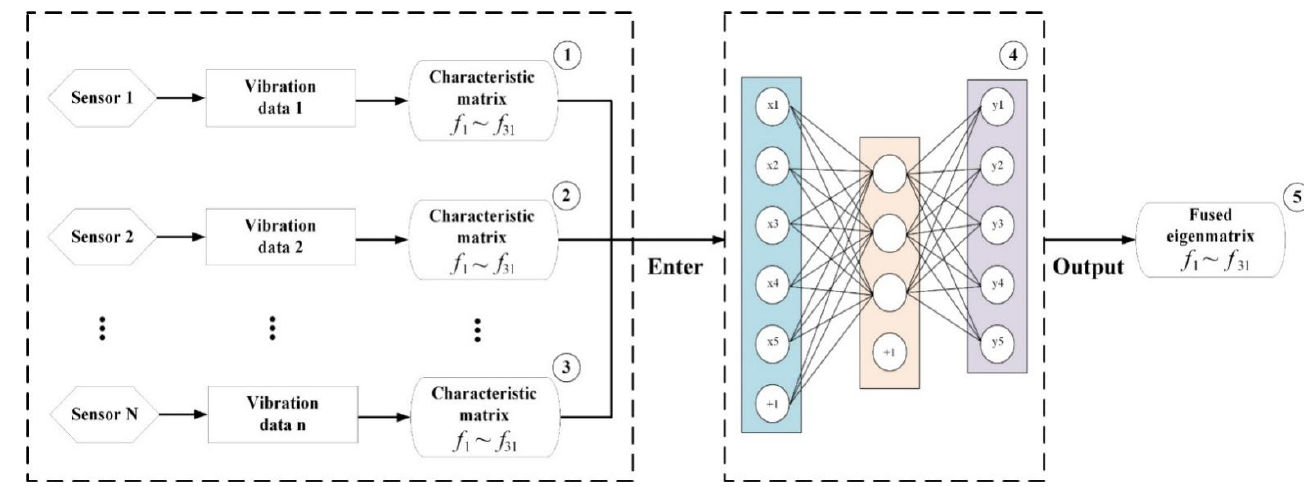
Figure 2. The SSAE-based fault feature fusion process.